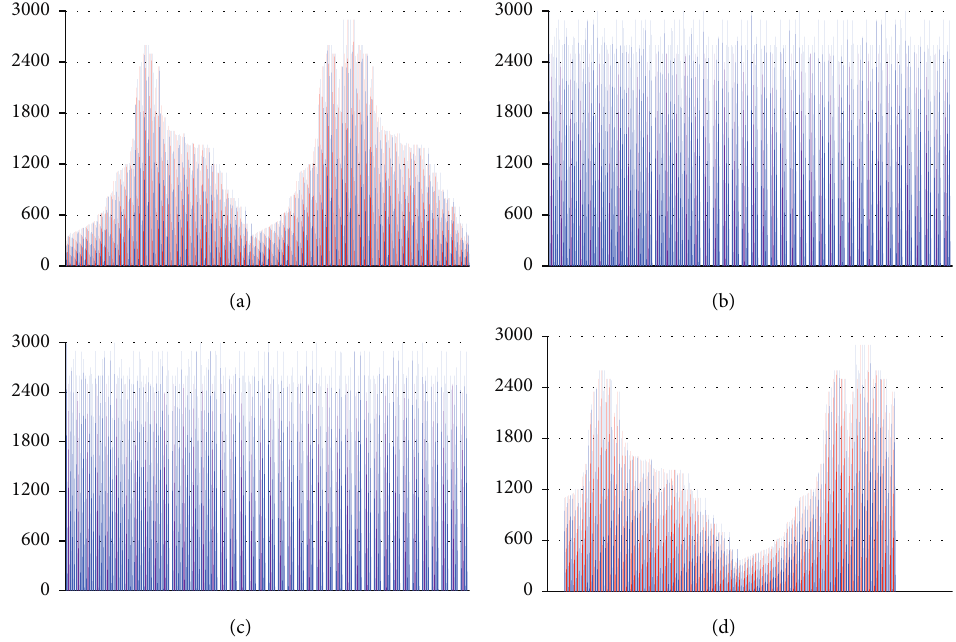
Figure 5: (a) Original and encrypted Lena image histogram. Mod 256-scrambling encrypted image histogram: (b) 4 ∗ 4 block; (c) 8 ∗ 8 block; (d) 16 ∗ 16 block.